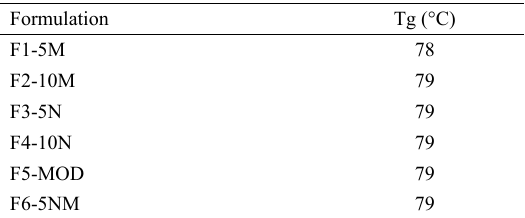
Table 4. Data obtained through TGA of the PVC formulations with micro and nano-CaCO Formulation